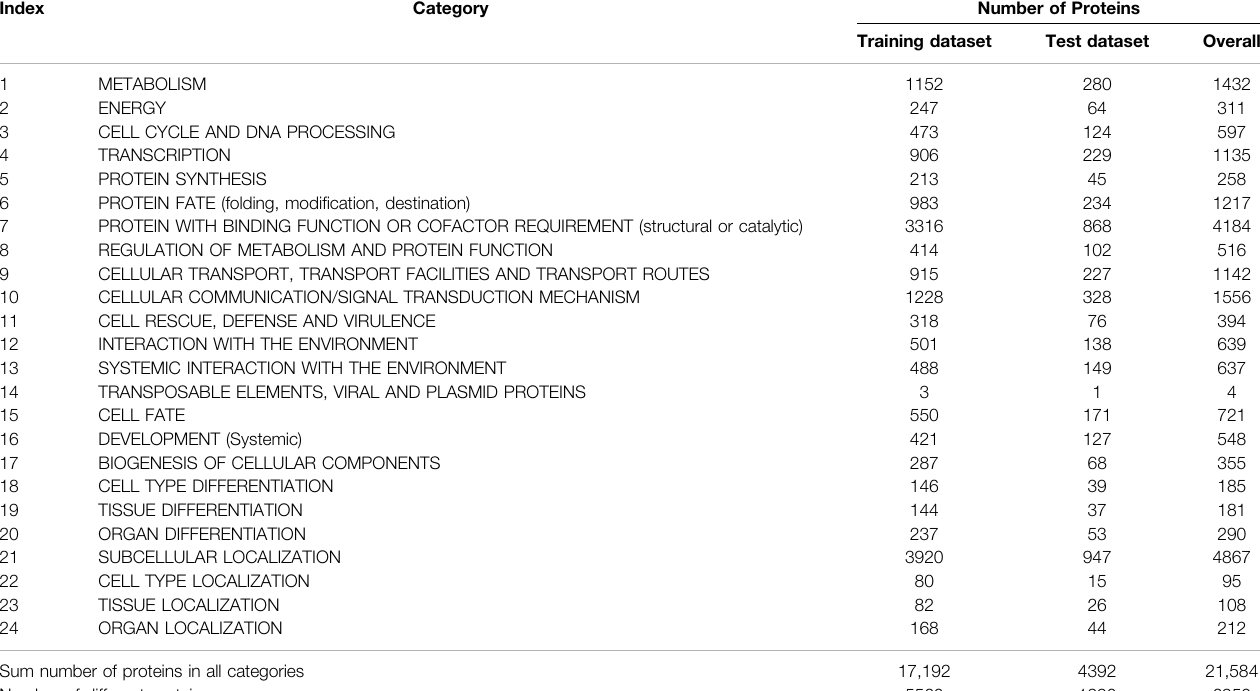
TABLE 1 | Number of proteins in each functional category.